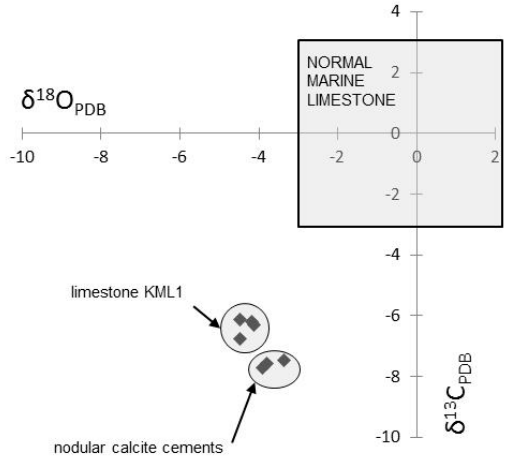
Figure 14. Cross-plot of δ 13 C and δ 18 O summarising the stable isotopic composition of limestone matrix and authigenic calcite associated with the KM bentonite.